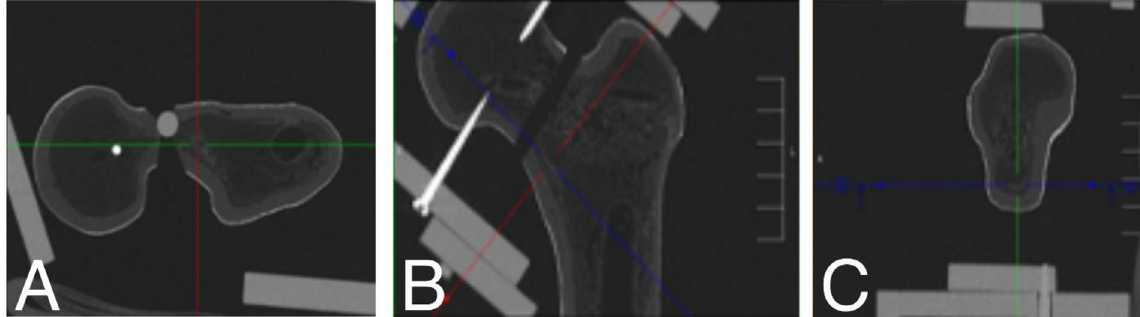
Fig 5. An exemplary 3D CT scan of the synthetic femoral bone model fixed by means of the goniometer is shown. The alignment of section planes in all three dimensions is depicted: A axial, B coronal and C sagittal view using Visage 1 .